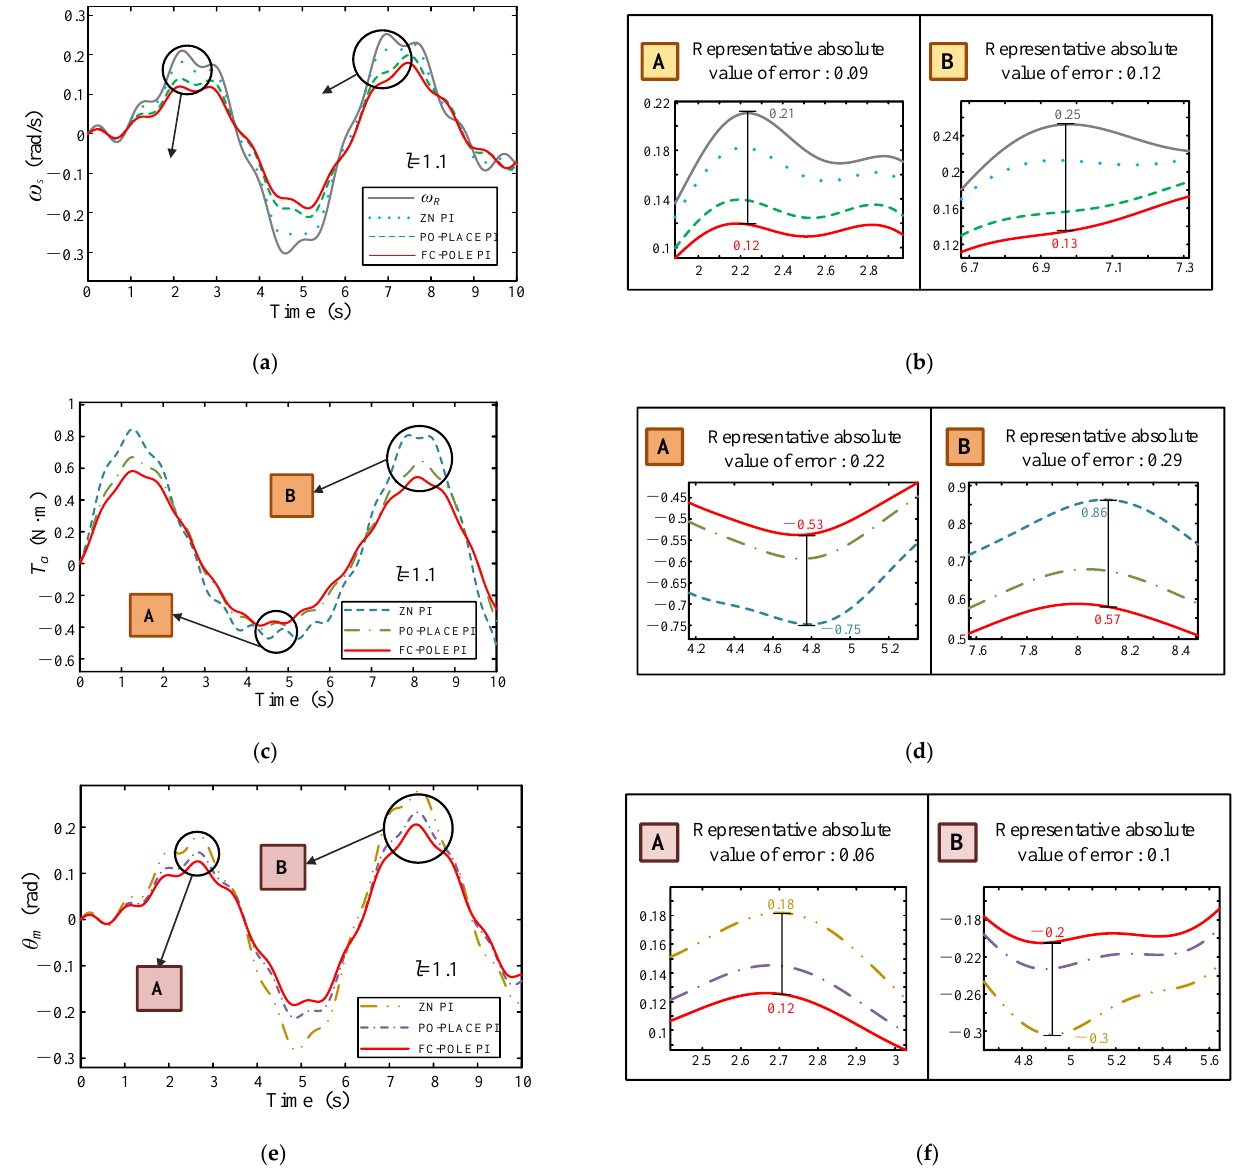
Figure 6. Output curve of double flexible body under parameter 1: ( a ) system rotation frequency diagram; ( b ) local amplification diagram of rotation frequency; ( c ) system torque diagram; ( d ) local amplification diagram of system torque; ( e ) system output angle diagram; ( f ) local magnification of system output angle.